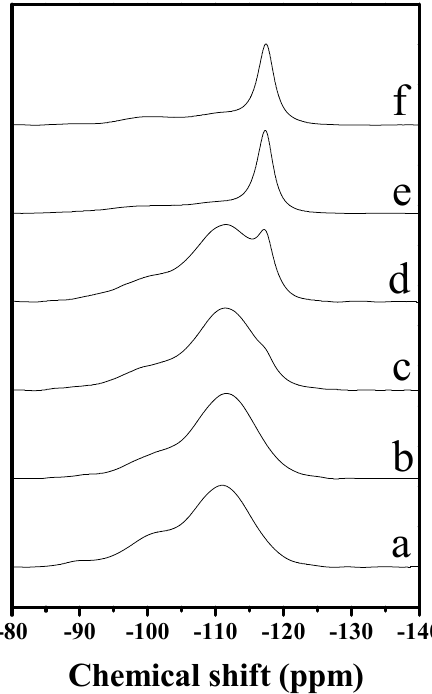
Figure 9. UV-Raman spectra of S–Si–SOD zeolites crystallized at 200 °C for ( a ) 0, ( b ) 8, ( c ) 12, ( d ) 14, ( e ) 16, and ( f ) 24, respectively.